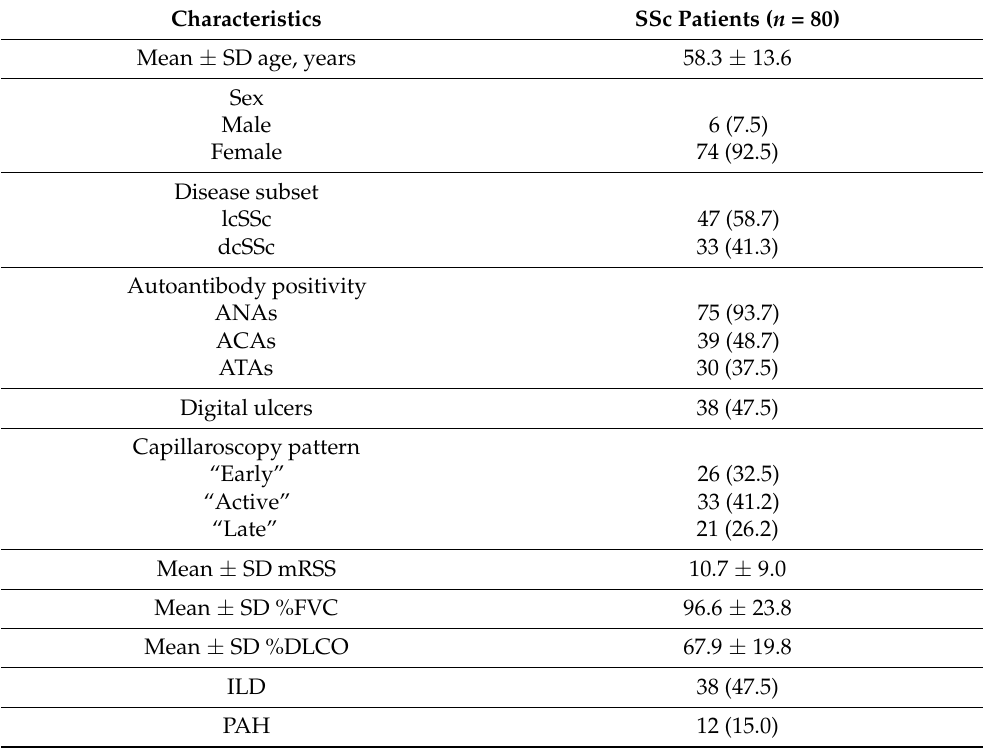
Table 1. Demographic, clinical, and serological characteristics of SSc